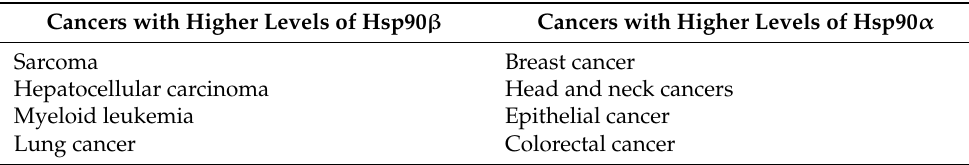
Table 3. Cancers with upregulation of specific Hsp90 isoforms 1 .